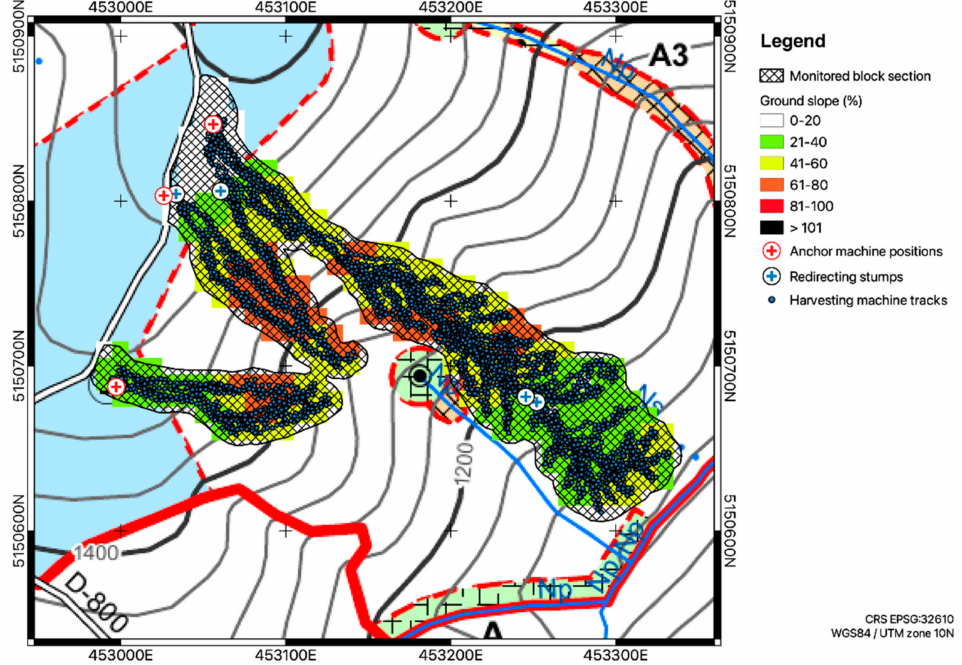
Figure 1. Extract of the harvest area map with evidence of harvesting and anchor machine positions, redirecting stumps position, and ground slope for the block section during the trial. Contour lines are in feet (1000 ft = 304.8